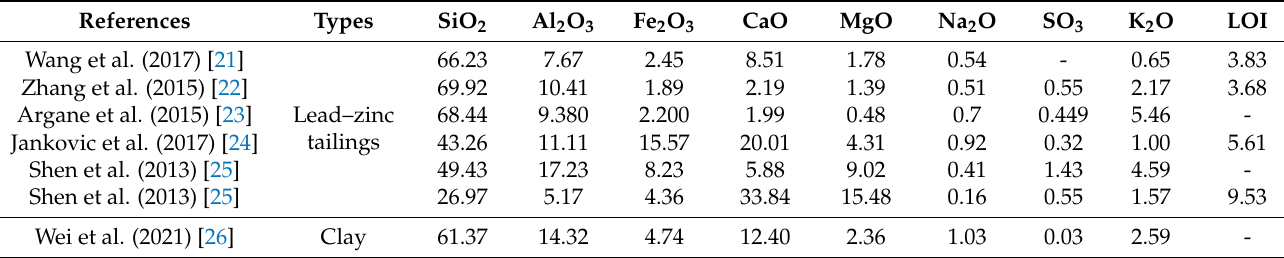
Table 1. Chemical composition of different lead–zinc tailings